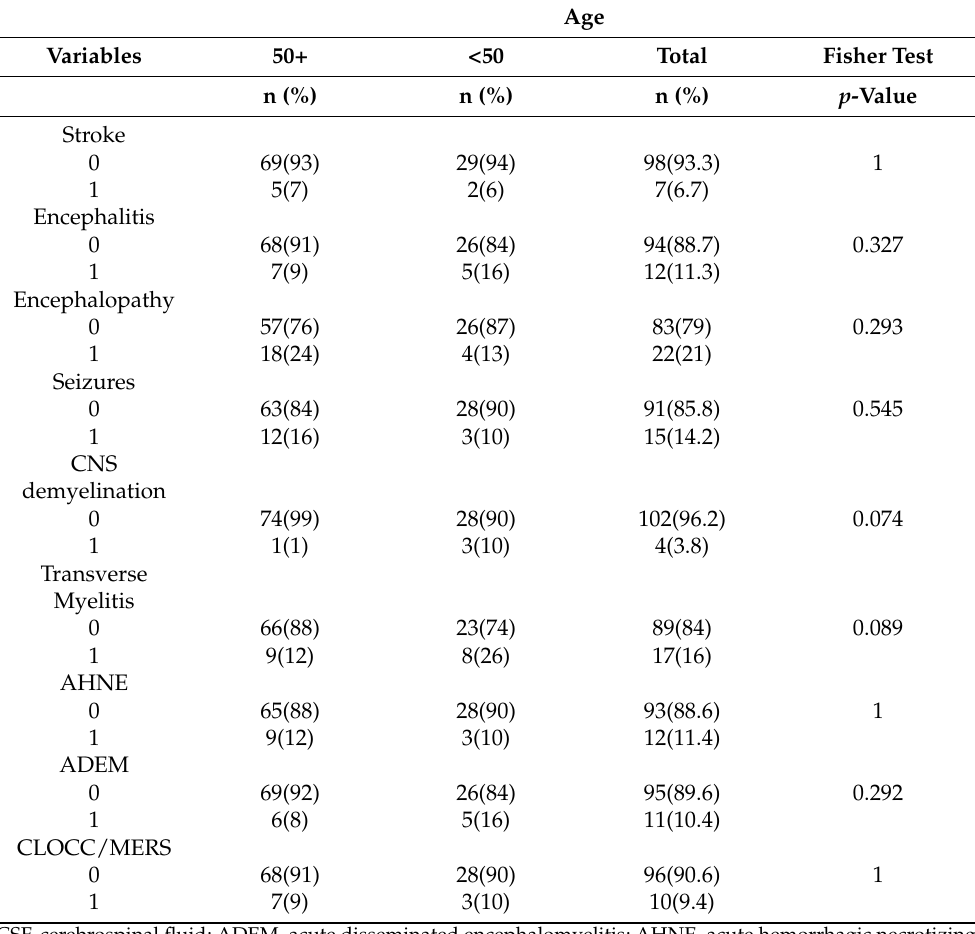
Table 3. Comparison of CNS manifestation by